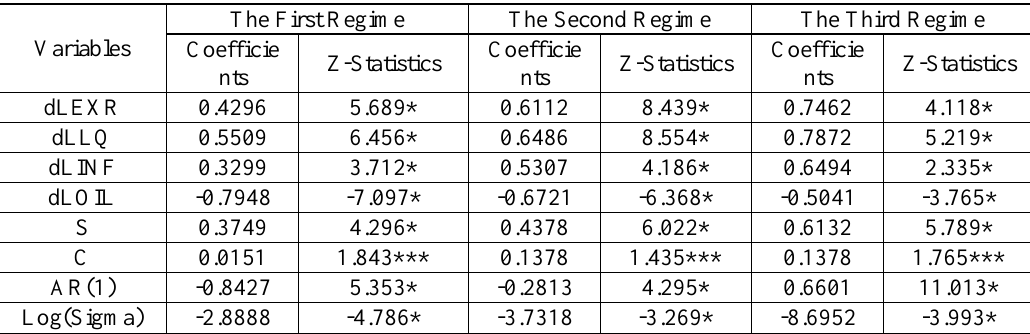
Table 4. The Results of Estimated Switching-Markov Model for the